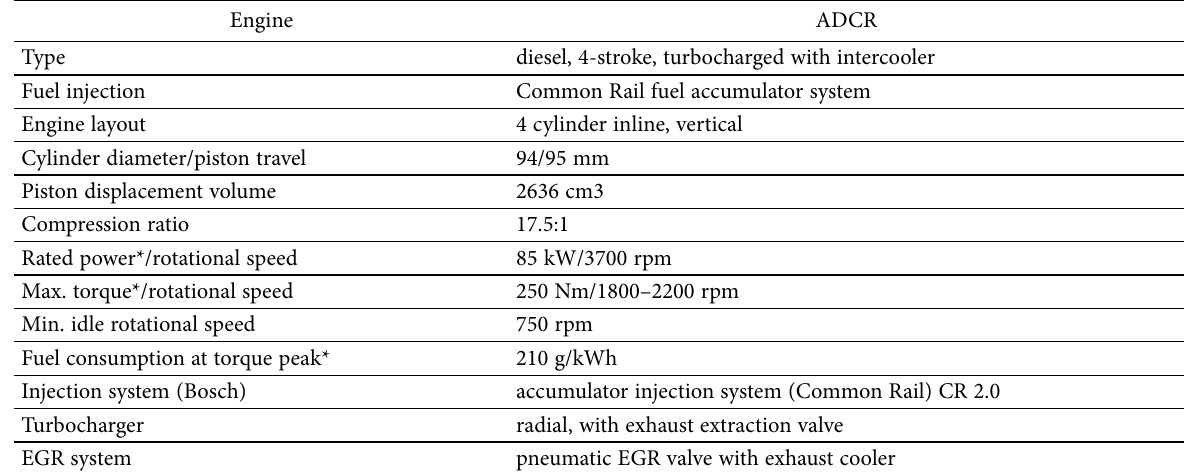
Fig. 1. An ADCR engine manufactured by Table 1. Technical details of an ADCR engine